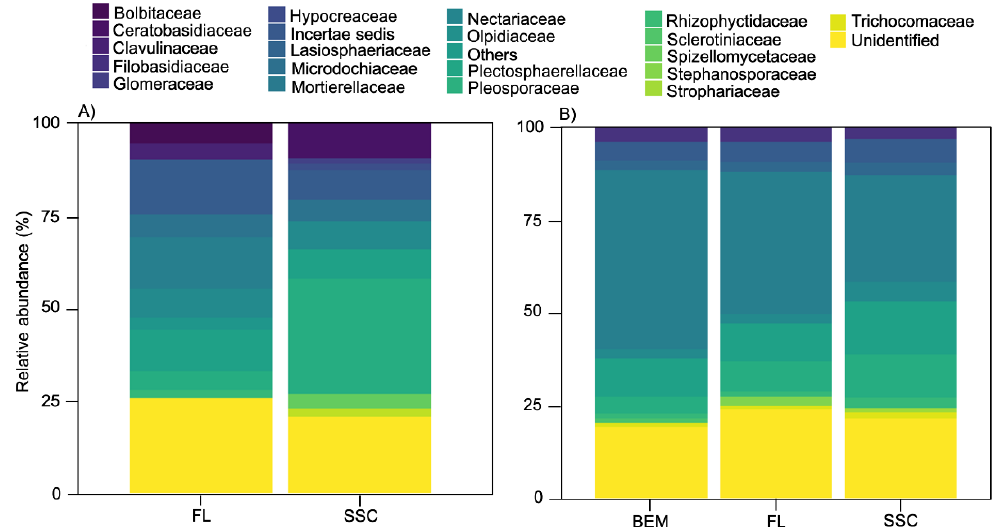
Figure 1. Taxonomic composition of root ( A ) and soil ( B ) fungal communities in different sampling times across all cultivars and replication blocks. BEM, before emergence; FL, flowering stage; SSC, senescence stage.